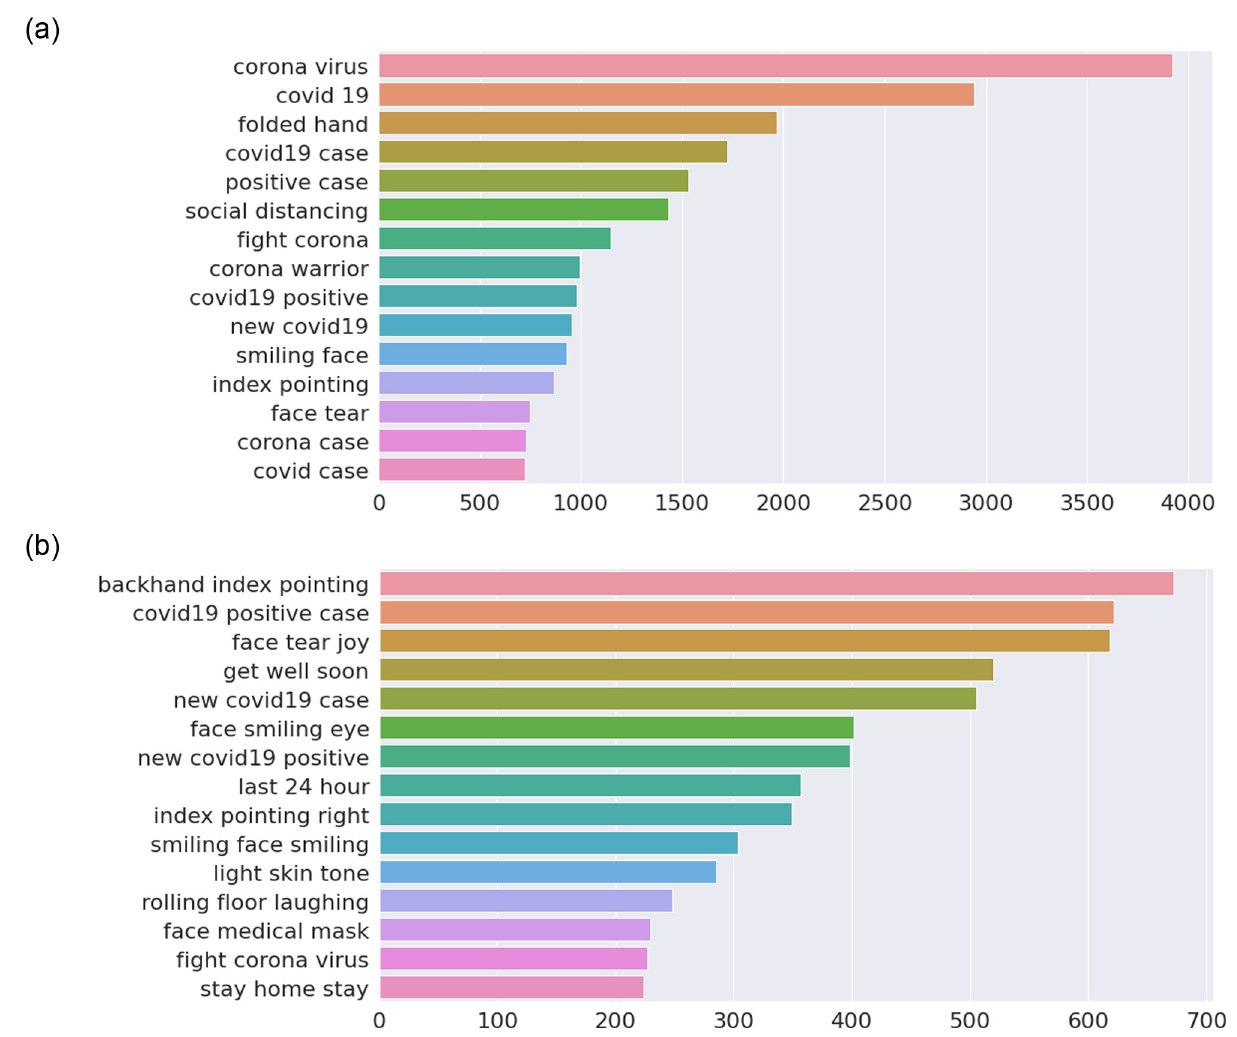
Fig 3. Bi-grams and tri-grams for case of India. Note that a combination of emoji’s such as “backhand—index—pointing”, “smiling—face”, and words have been used. (a) Bi-grams. (b)